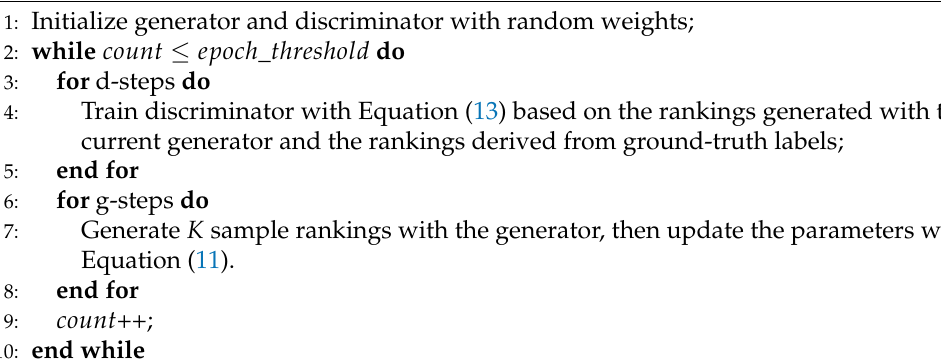
Algorithm 1 Listwise adversarial